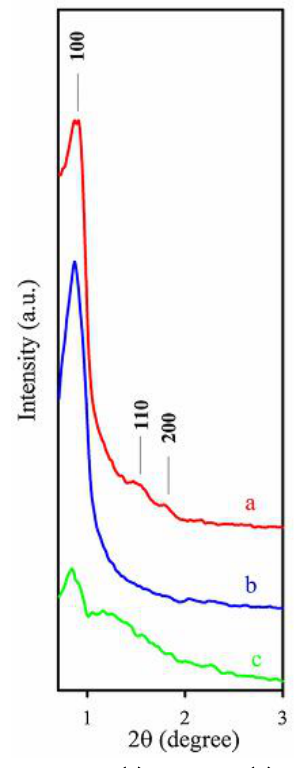
Fig. 2. XRD patterns for (a) SBA-15, (b) SBA-Pr-NH (c) SBA-SPS-Q